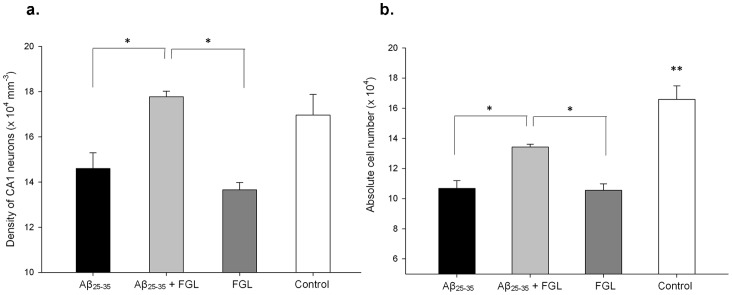
The density and total number of CA1 pyramidal cells in the right dorsal hippocampus.Immunocytochemistry (NeuN antibody in conjunction with DAB) and the optical fractionator method were used to establish cell density within the CA1. Cell density (a) was multiplied by the volume of the dorsal CA1 SP to establish total number (b). The data was analysed using a one-way ANOVA and Tukey’s post-hoc test. The Aβ25–35+FGL group had a significantly greater density (a) and total number (b) of pyramidal cells in the CA1 SP than compared with the Aβ25–35 alone and the FGL alone groups, whilst the control group had significantly more pyramidal cells than all of the other groups, regardless of the groups cell density. (*P<0.05, **P<0.01). Mean ± SEM, n = 4.